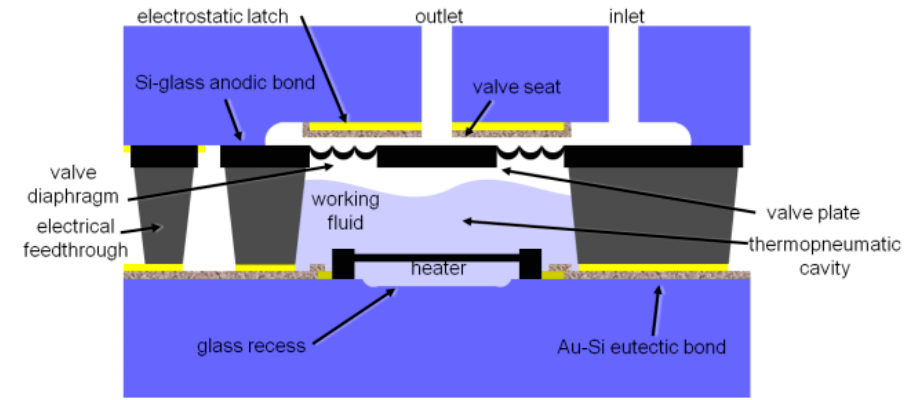
Figure 12. Cross-section view of thermopneumatic microvalve [91].